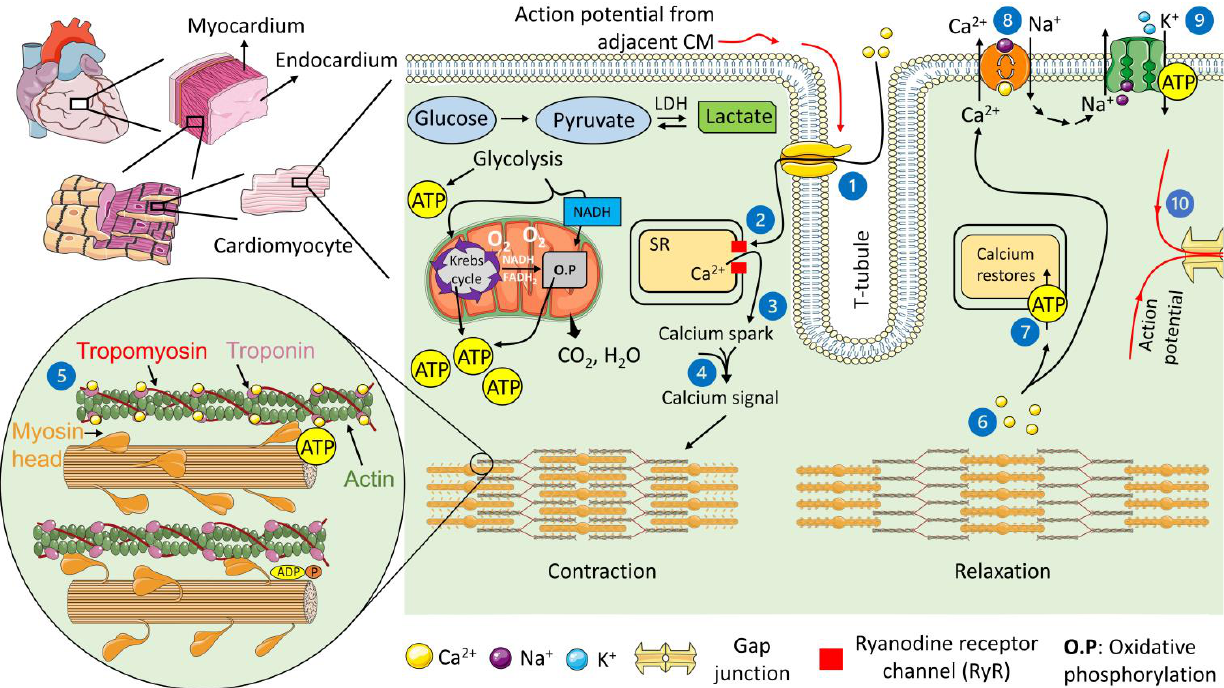
Figure 3. Contractile machinery of the heart: (1) Voltage-gated calcium channels open. Influx of Ca 2+ ions. (2) Calcium-induced calcium release through RyR receptor channel. (3) Local release causes calcium spark. (4) All sparks sum up to create calcium signal. (5) Ca 2+ binds to troponin to initiate contraction. (6) Upon relaxation, Ca 2+ unbinds from troponin. (7) Ca 2+ is pumped backed to sarcoplasmic reticulum (SR). (8) Ca 2+ and Na + are exchanged with each other through exchangers. (9) Na + gradient is maintained through sodium-potassium pump. (10) The action potential travels to the adjacent CM through the gap